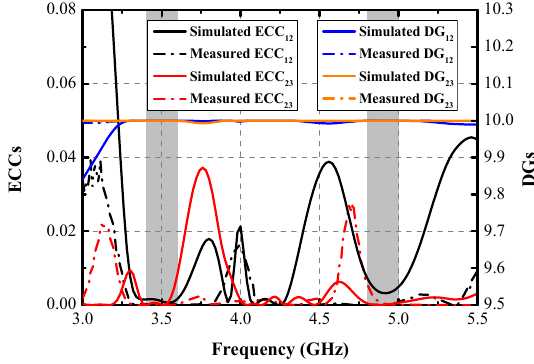
Figure 13. Simulated and measured ECCs and DGs.